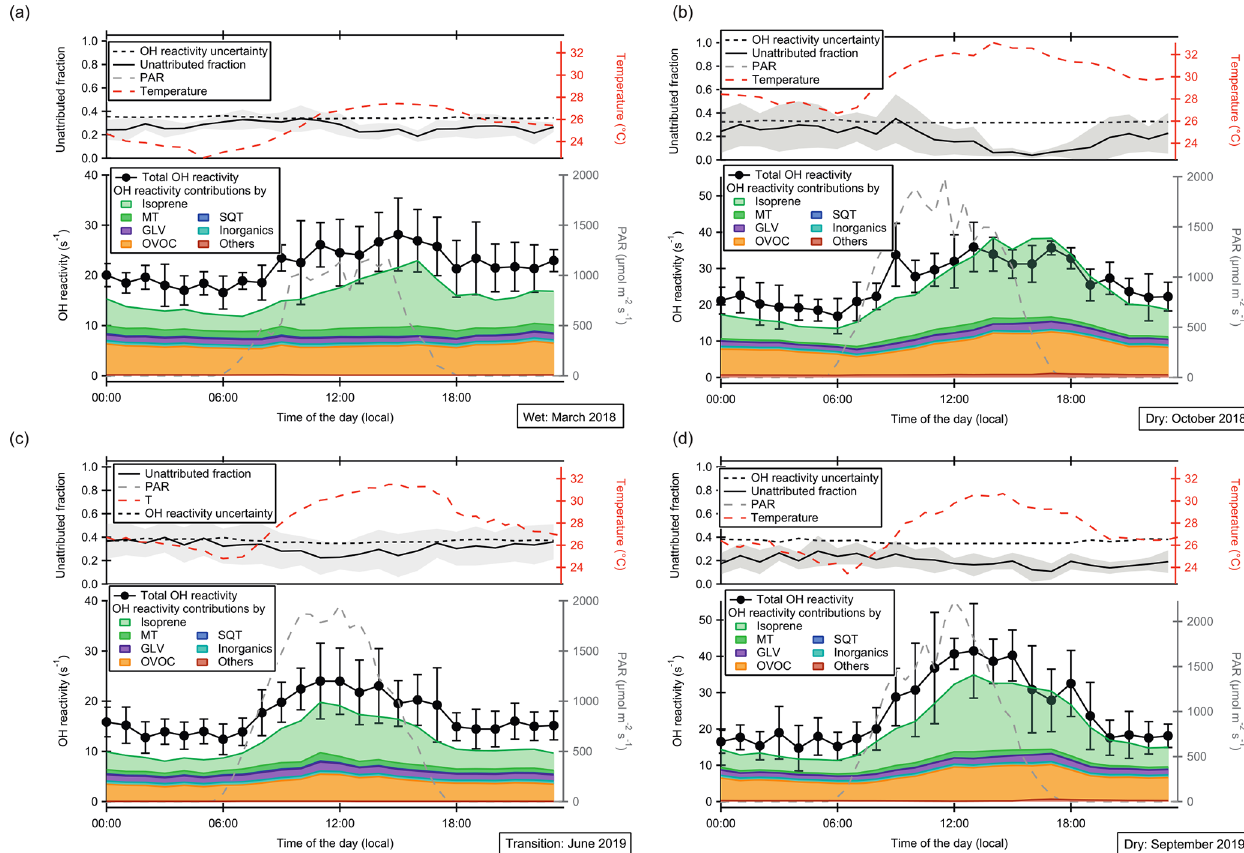
Figure 4. Diel cycles of total OH reactivity, speciated OH reactivity by class of compounds, photosynthetically active radiation (PAR), temperature and unattributed OH reactivity at 80ma.g.l. for four measurement periods: (a) March 2018, (b) October 2018, (c) June 2019, (d) September 2019. The individual compounds included in each class are listed in Table S1. Values are averages of several days of measurement (5–13d; see Sect. 2.2). Error bars (for measured OH reactivity) and shaded areas (for unattributed reactivity) represent the standard deviation of the data. The unattributed fraction does not depend on height (see Fig. S2); therefore data from 80m are shown as a representative example. Note that the axis range of (a) and (b) differs from that of (c) and (d) for better visibility of the reactivity contributions.